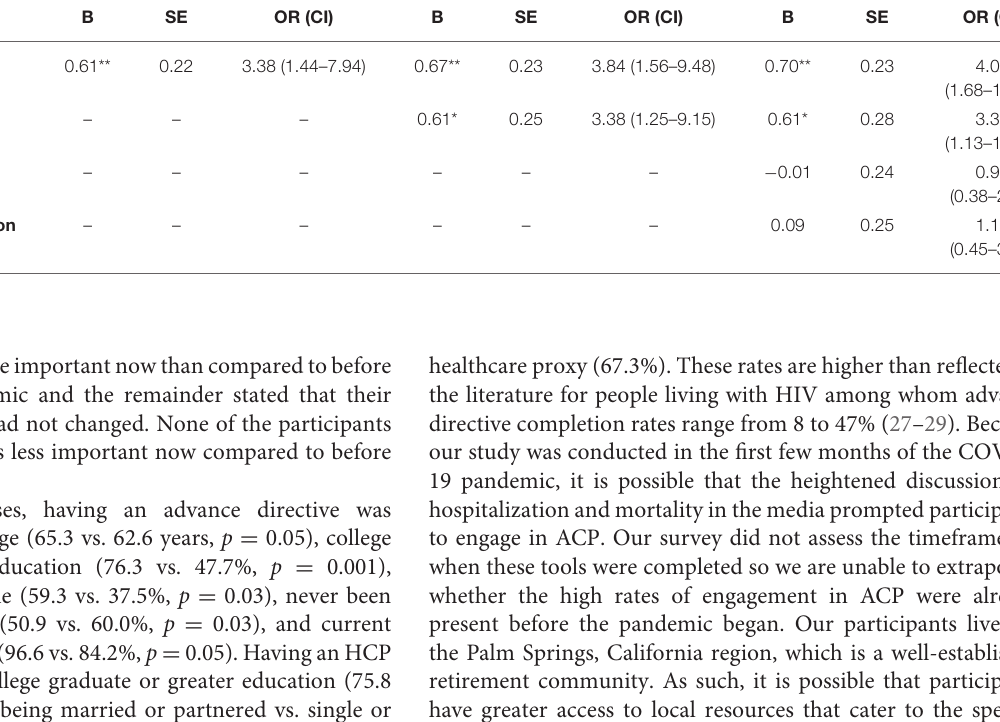
TABLE 2 | Logistic regression models predicting belief that advance care planning is more important now compared to before the COVID-19 pandemic.